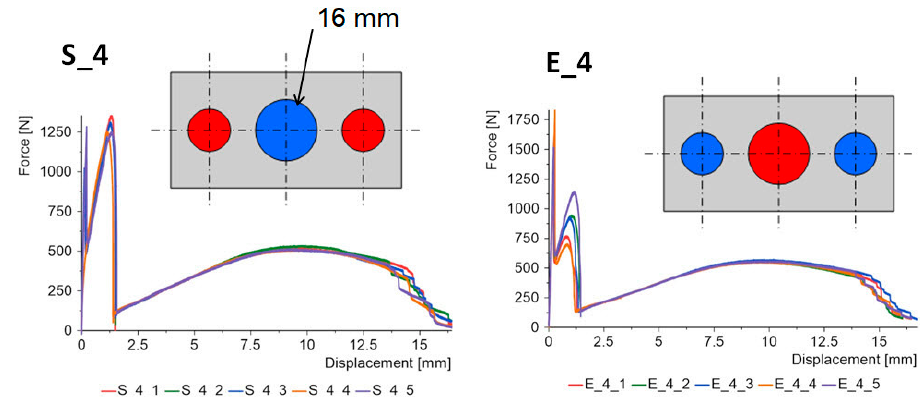
Figure 9. Triple-adhesive samples, batch 3.